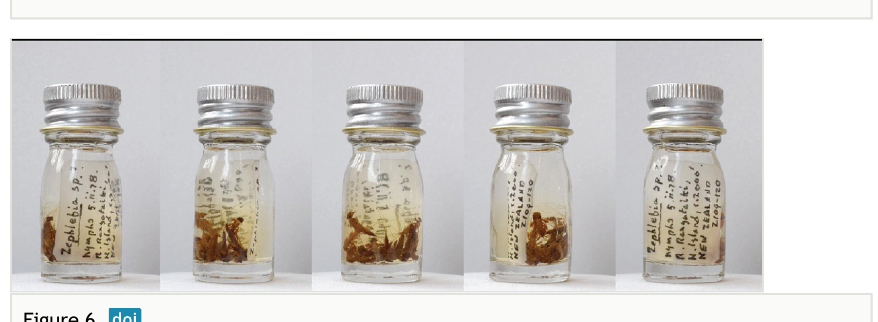
Figure 5. MALICE: Image output of MALICE including original output image (a) and the final processed image (b).